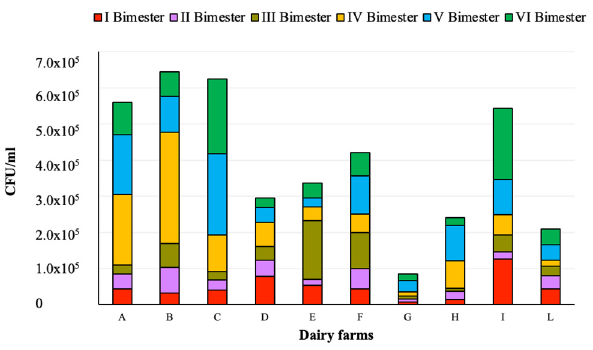
Figure 1. Somatic cell counts in raw milk samples collected from the investigated dairy farms.